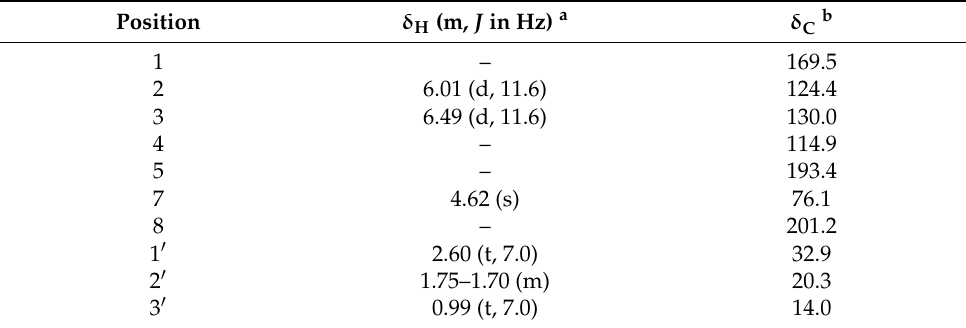
Table 1. 1 H and 13 C chemical shift (CD 3 OD) for (2 Z )-cillifuranone ( 1